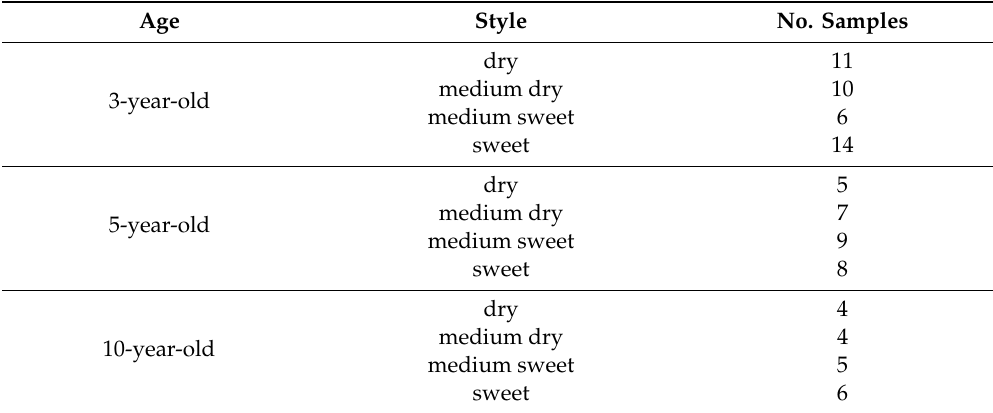
Table 2. Number of samples analyzed to assess the odor relevance of sotolon in MW blends according to age and